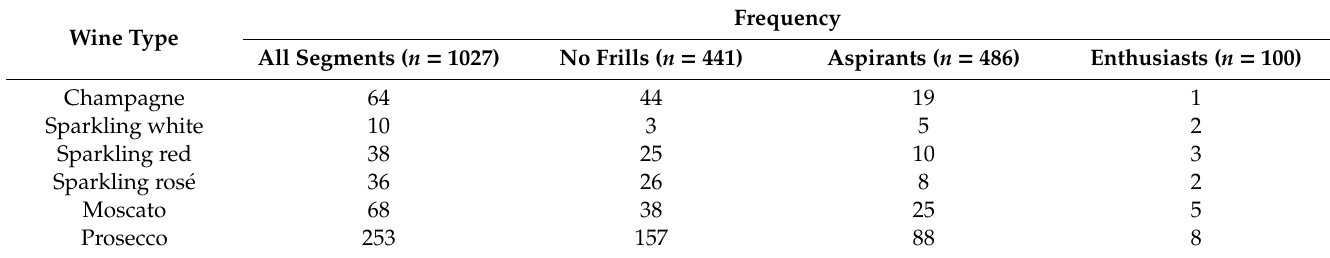
Table 5. Frequency of Fine Wine Instrument consumer segments’ unfamiliarity with di ff erent sparkling wine